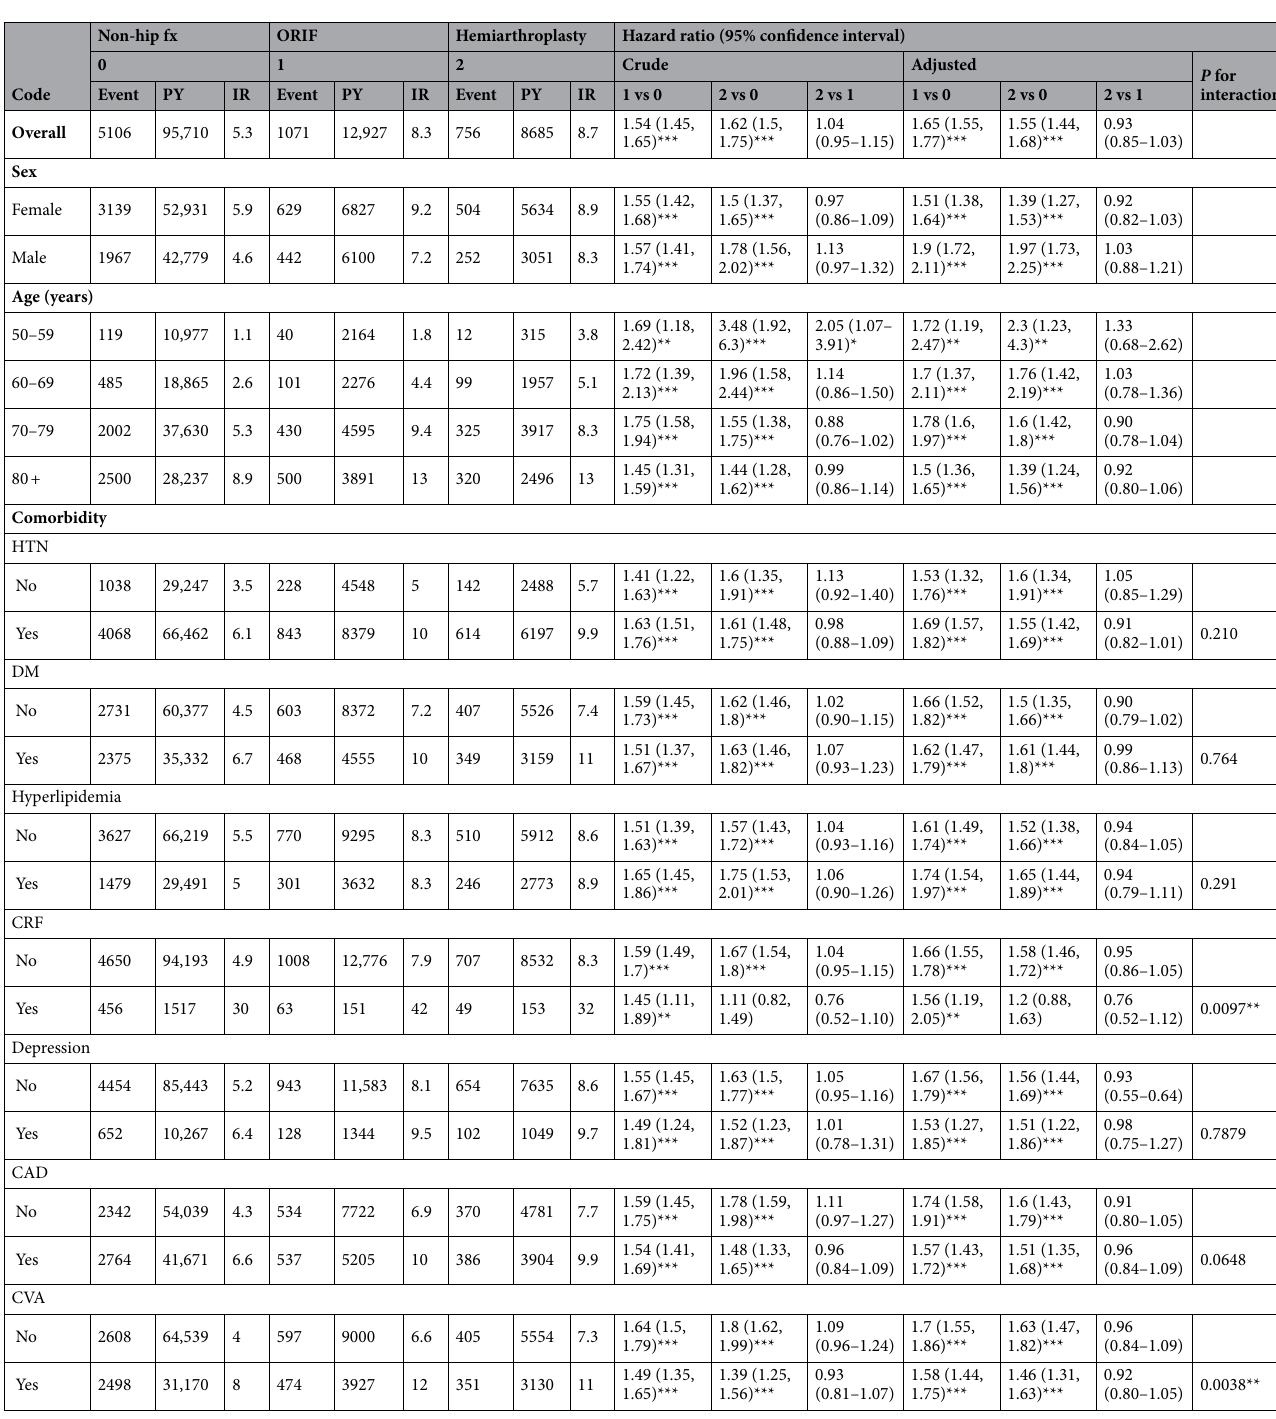
Table 2. Incidences and hazard ratios of S-UTI for ORIF, hemiarthroplasty, and non-hip fx cohorts. Adjusted hazard ratio for controlling for sex, age, and every comorbidity in Table 3. HR hazard ratio, IR incidence rate, per 100 person-years, CAD coronary artery disease, CI confidence interval, CRF chronic renal failure, CVA cerebrovascular accident, DM diabetes mellitus, fx fracture, HTN hypertension, ORIF open reduction and internal fixation, PY person-years, S-UTI severe urinary tract infection. * P < 0.05, ** P < 0.01, *** P <